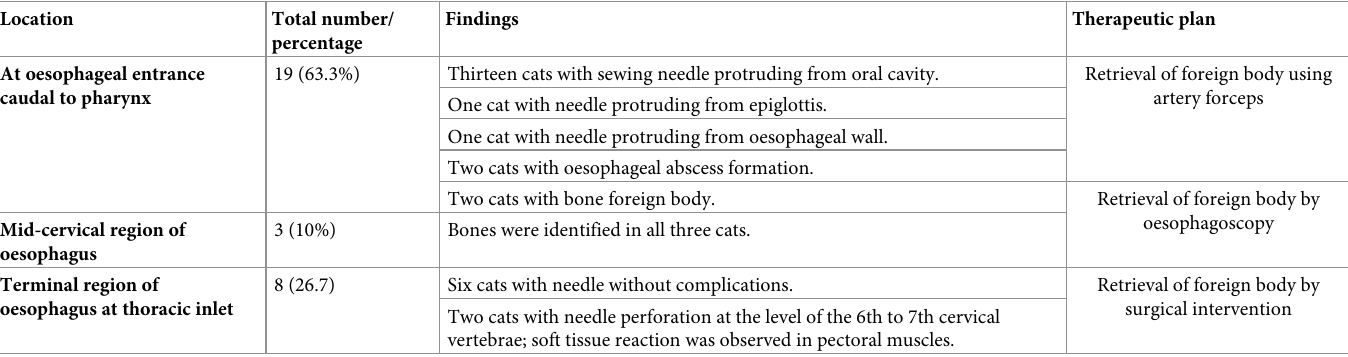
Table 2. Locations, findings and therapeutic plans associated with oesophageal foreign bodies in